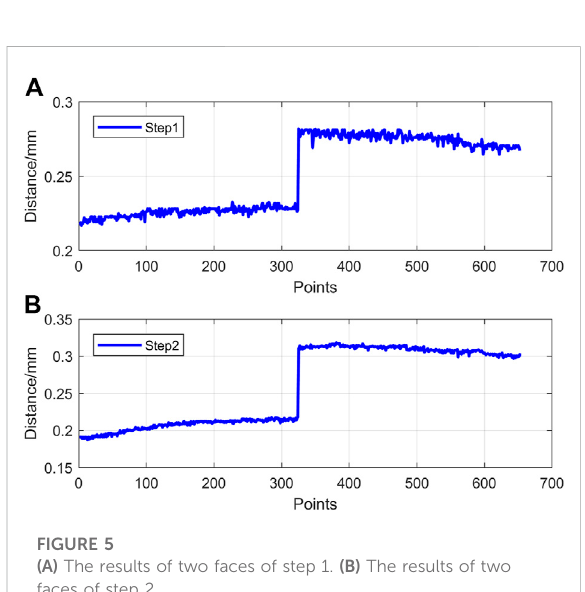
FIGURE 5 (A) The results of two faces of step 1. (B) The results of two faces of step 2.